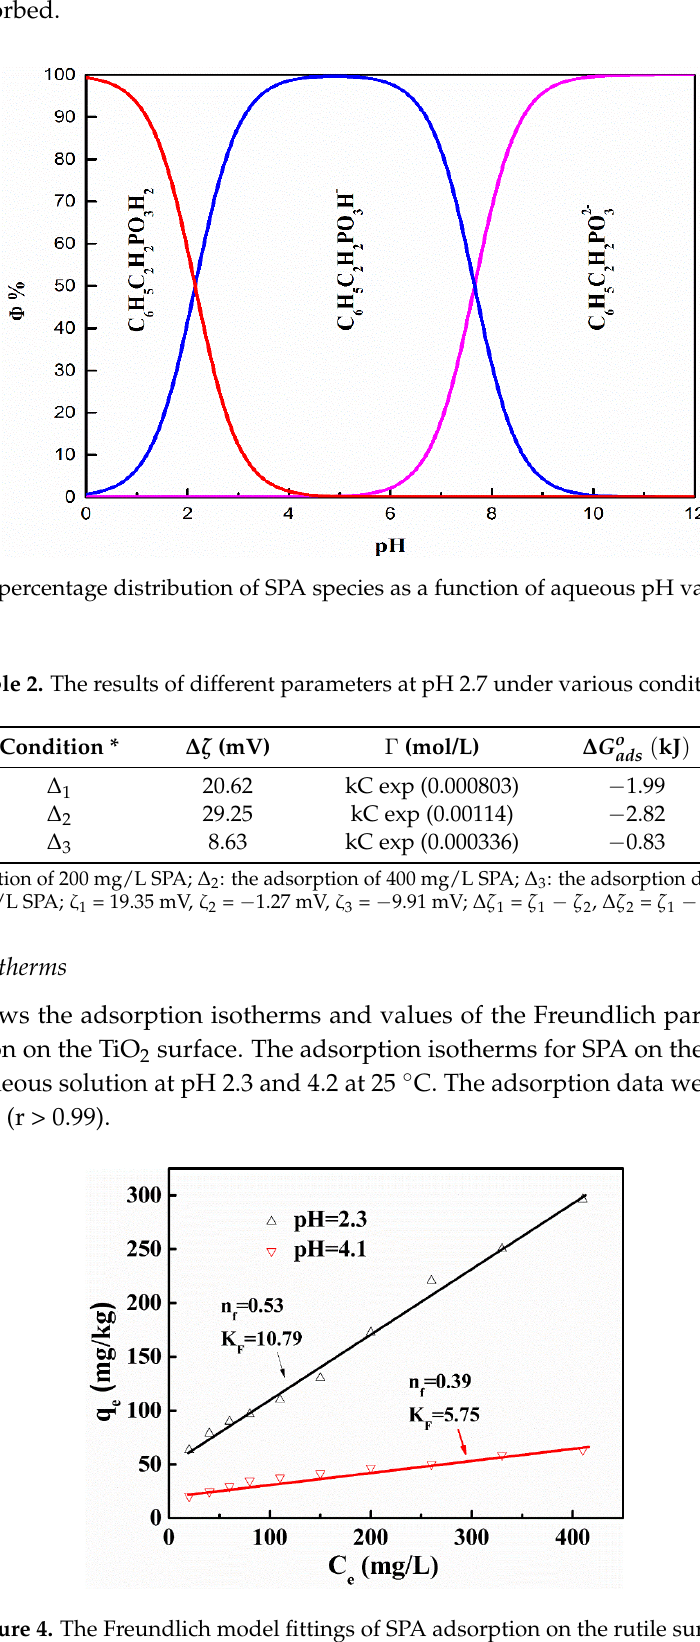
Figure 4. The Freundlich model fittings of SPA adsorption on the rutile surface.